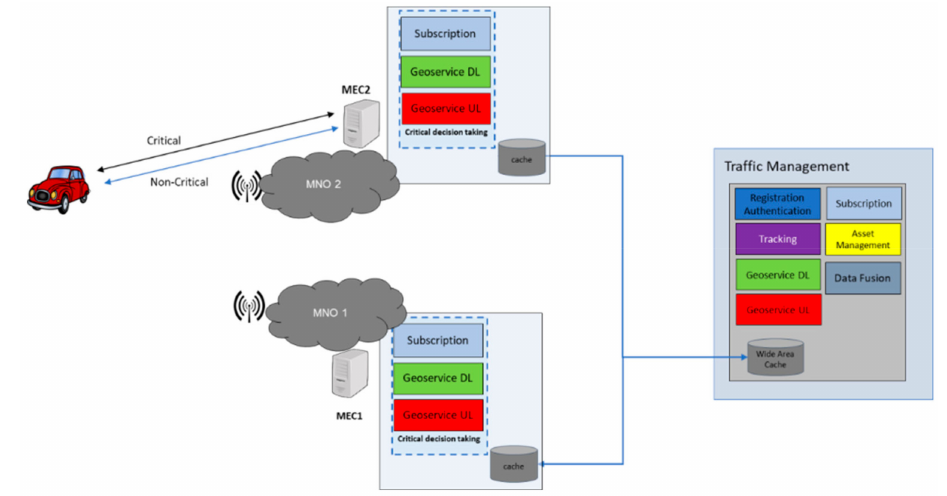
Figure 5. ACCA component block diagram in a cross-border (cross-MNO)